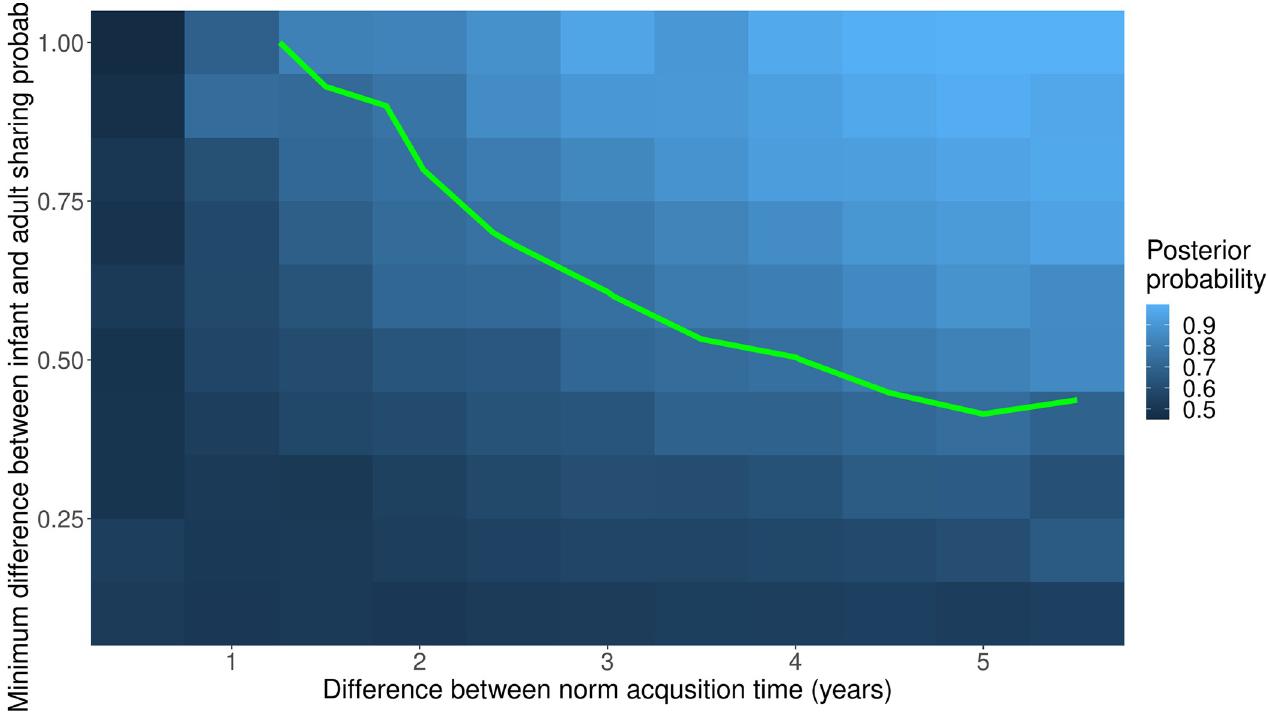
Fig 5. Mean posterior probability that the developmental process for intra-ethnic norm acquisition reaches the 95% complete point earlier than the corresponding process for inter-ethnic norms, based on 30,000 simulations in total. The red line shows our chosen threshold of 0.75. When the difference between norm acquisitions times (shown in years on the x-axis) is only 1 year or less, our sample size is not able to detect this with confidence. Greater differences can be detected if the adult norms differ sufficiently from the infant behaviour. The y-axis corresponds to the minimum absolute difference between the infant sharing probability and the two adult norm sharing